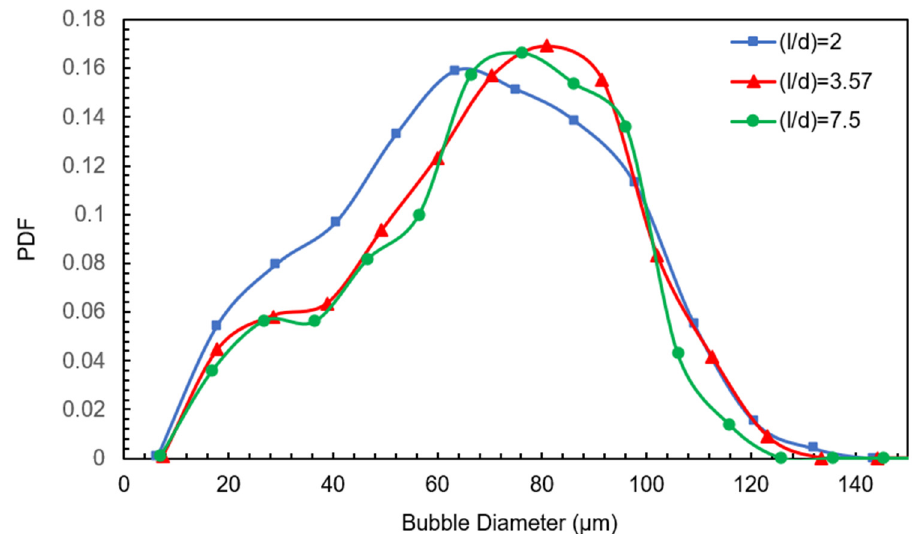
Figure 11. Distribution of bubble diameters at the outlet section of the diffuser for different l/d ratios. (Water flow rate = 8.21 L/min, air flow rate = 0.1 L/min).